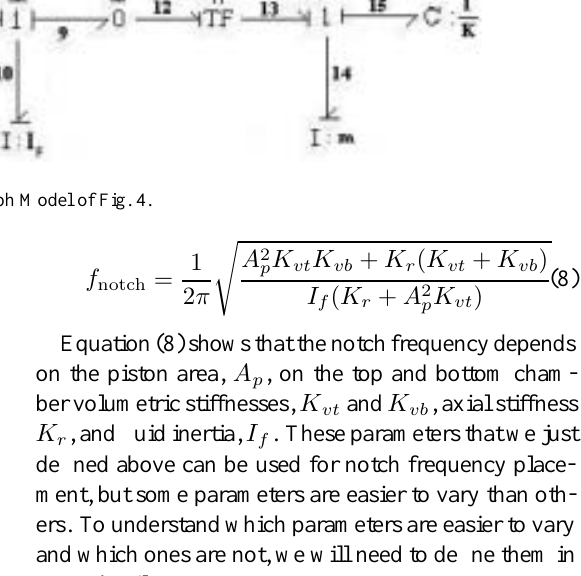
Fig. 5. Bond Graph Model of Fig.